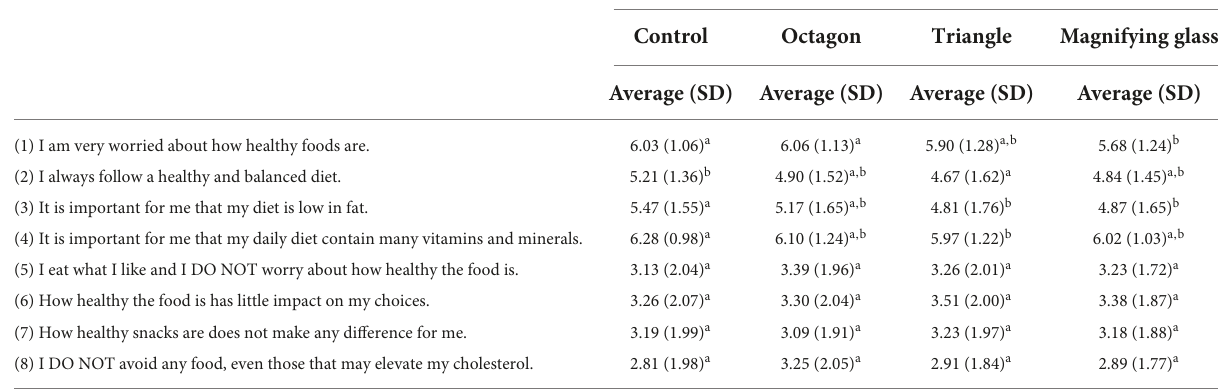
TABLE 8 Participant interest in health, evaluated through the General Health Interest Questionnaire, by experimental condition.